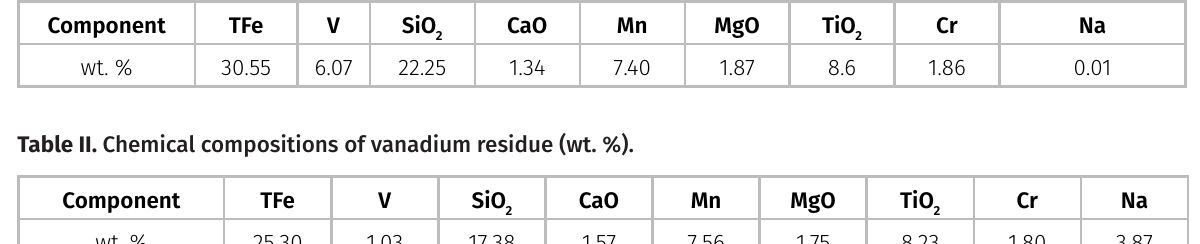
Table I. Chemical compositions of vanadium slag (wt. %). Component